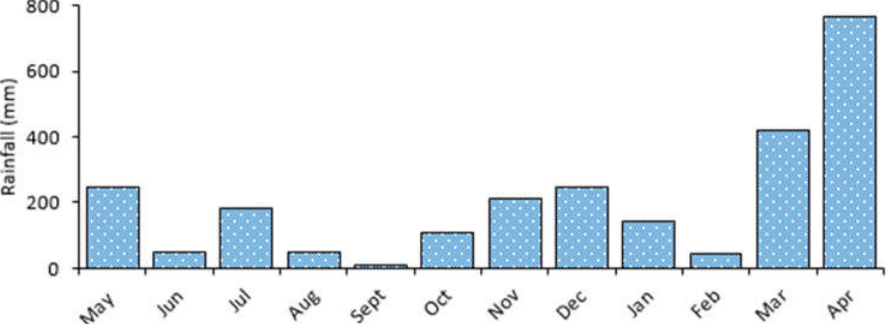
Figure 3. Monthly average rainfall from May 2020 to April 2021 for the Arusha National Park, northern Tanzania [52].